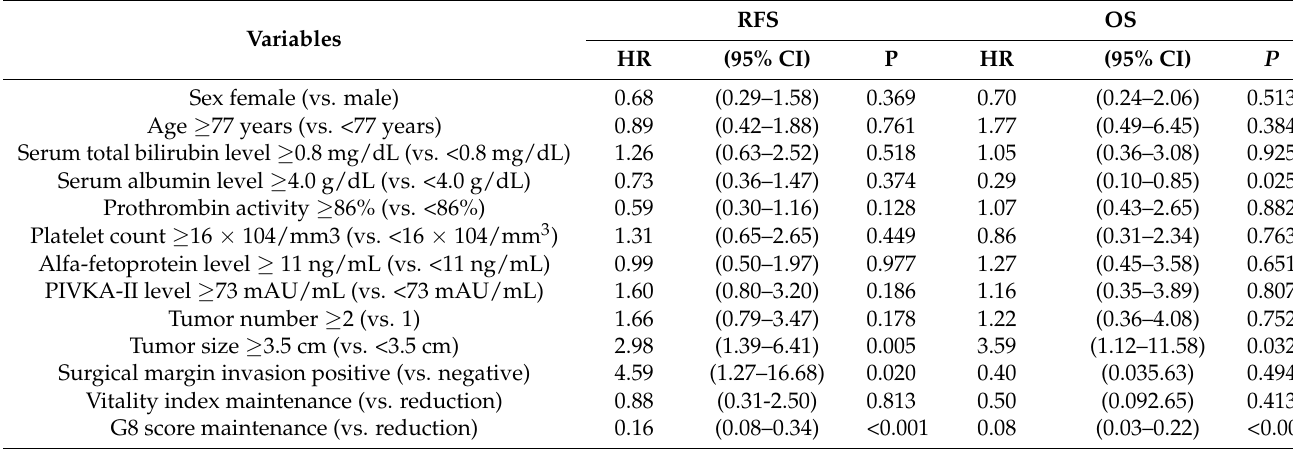
Table 5. Multivariate Cox regression analysis of recurrence-free survival and overall survival in patients aged ≥ 70 years with hepatocellular carcinoma who underwent hepatic